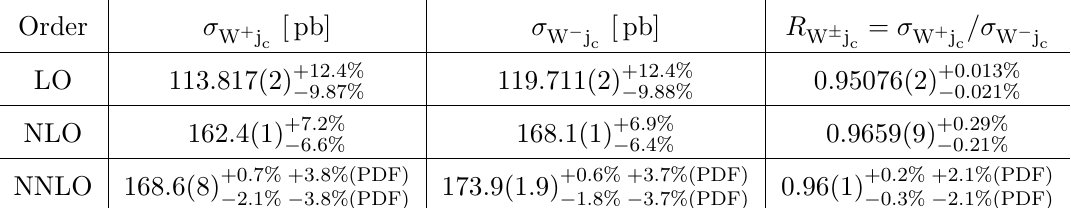
, pp → W − j , and their ratios at the LHC at Table 1 . Fiducial cross sections for pp → W + j c c √ s = 13 TeV at LO, NLO, and NNLO QCD. The digit in parenthesis indicates the Monte Carlo statistical error while the sub- and super-script in per cent indicate the scale variation. In addition, the PDF variation is provided for the NNLO QCD predictions. The full CKM matrix and the NNLO NNPDF3.1 set with α = 0 . 118 are used for all predictions. The c-jets are defined with the s k T CA algorithm with the at least one c-jet